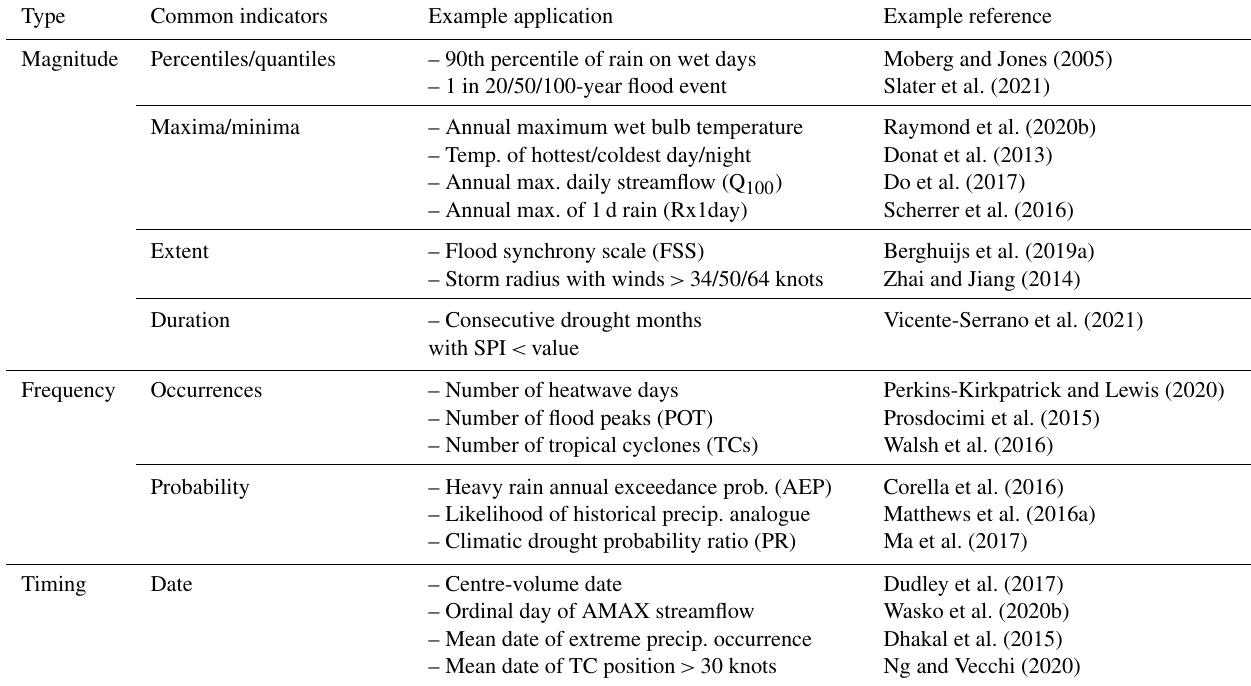
Table 1. Examples of indicators employed for the detection of nonstationarity in weather and water extremes. More detailed tables of metrics can be found in Donat et al. (2013) for temperature and precipitation or Ekström et al. (2018) for a detailed list of hydroclimatic